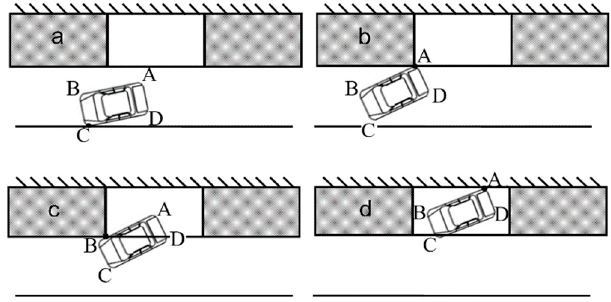
Figure 3. Possible Collisions of Parallel Parking.